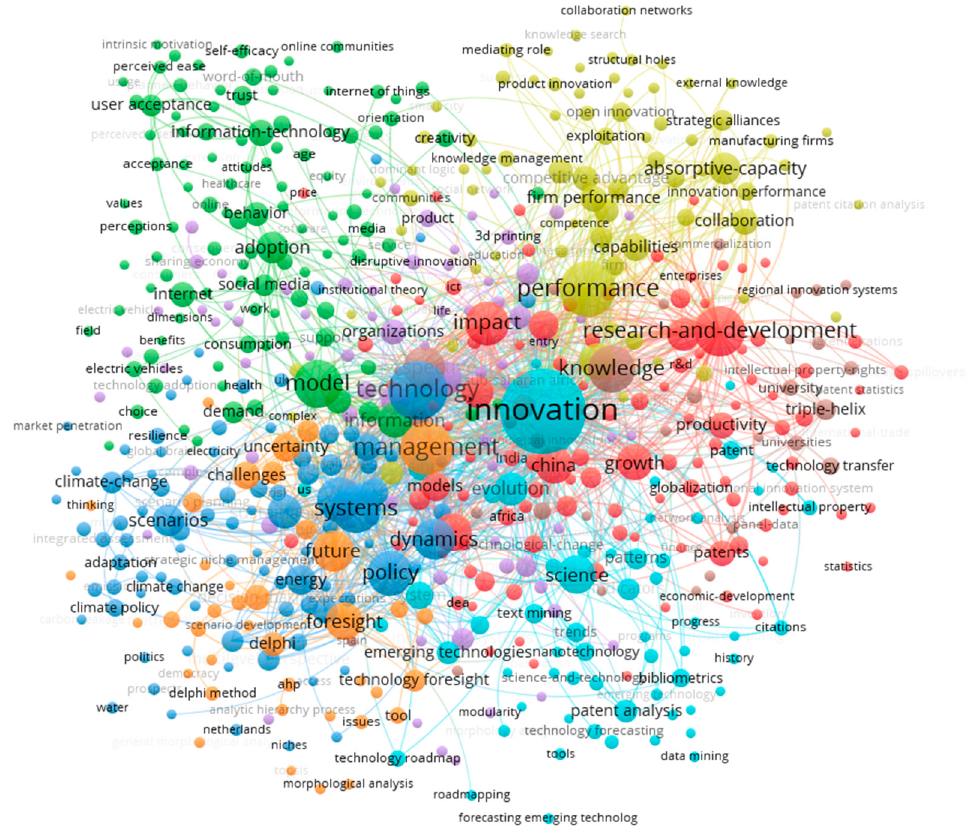
Figure 3. VOS Viewer: keywords from the Technological Forecasting and Social Change Journal. Eight clusters were detected in this journal; the total number of keywords was 586.